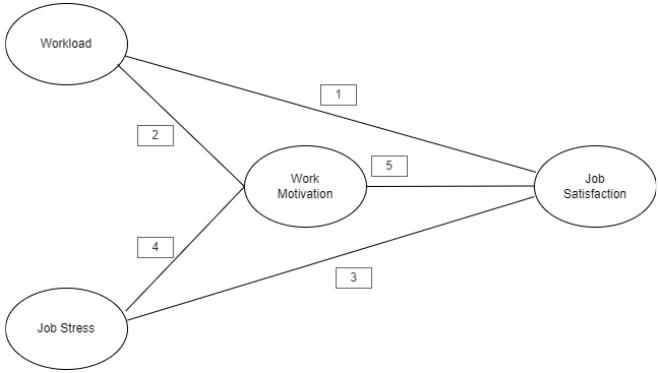
Figure 1: Conceptual Model of the Study; Source: Authors,